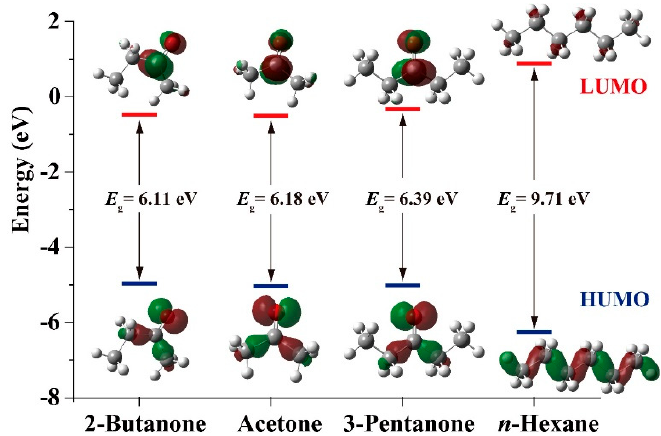
Figure 8. HOMO/LUMO energy levels, HOMO–LUMO gaps and orbital coefficients for 2-butanone, / 6-311G (d, p) acetone, and 3-pentanone and n -hexane from B3LYP/6-311G (d, p) calculations. acetone, and 3-pentanone and n -hexane from B3LYP